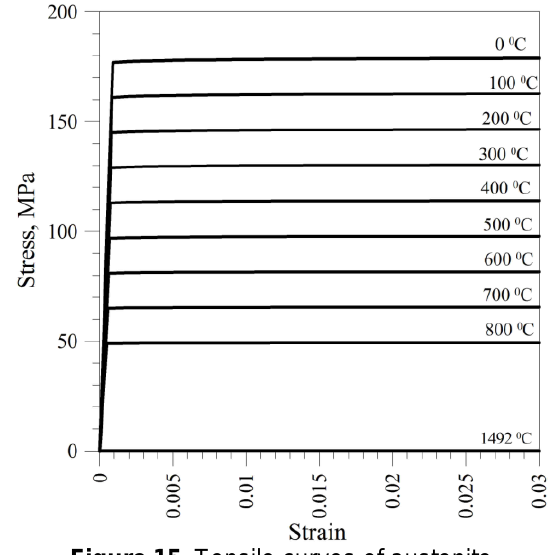
Figure 15. Tensile curves of austenite